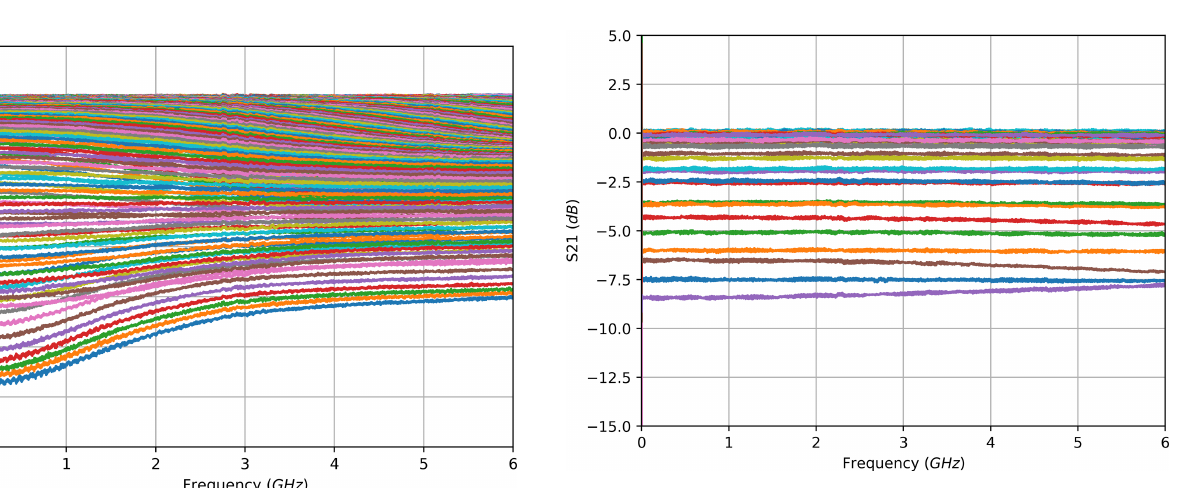
Figure 16. Analytically modelled amplitude for FBG in reflection configuration.